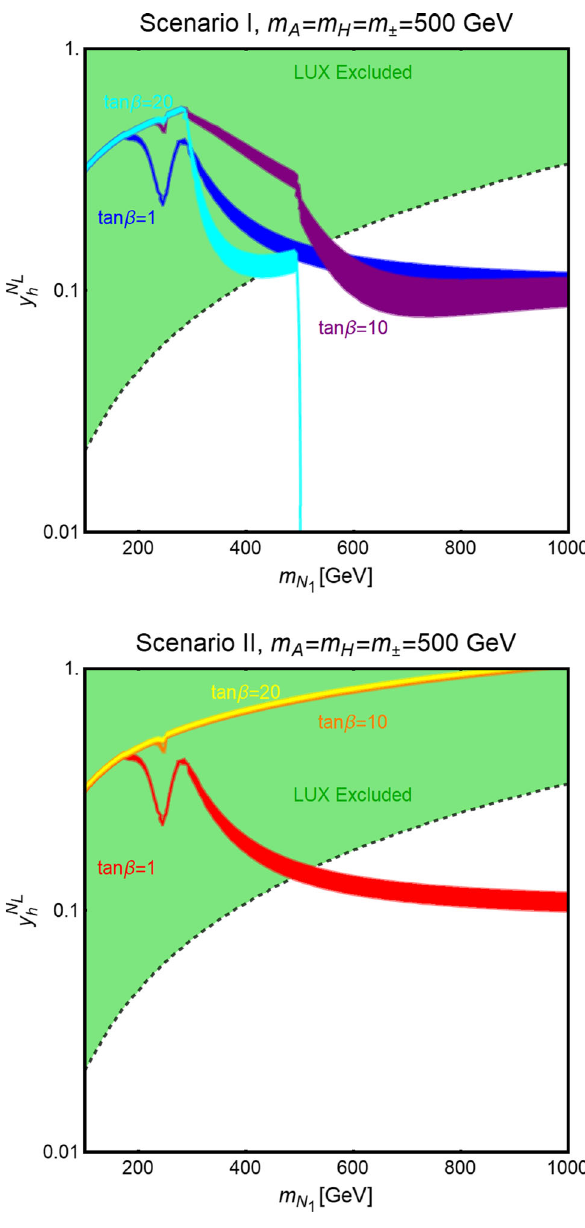
Fig. 17 Main constraints from dark matter phenomenology, i.e. in the two proposed scenarios for flavor conserving VLF sector